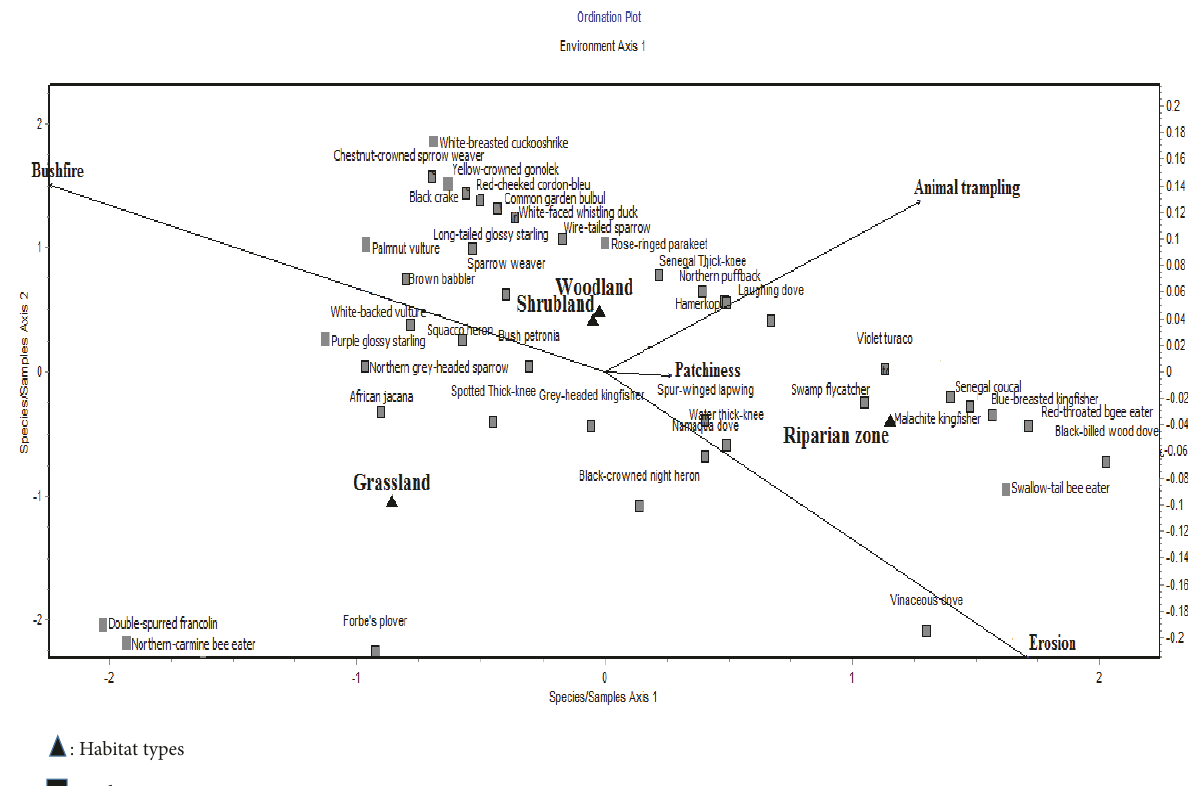
Figure 6: Canonical correspondence (CCA) ordination diagram, showing the relationship between environmental disturbances and bird species across the four habitat types in the dry season. The arrows represent each of the environmental variables plotted pointing in the direction of maximum change of explanatory variables across the four habitats.